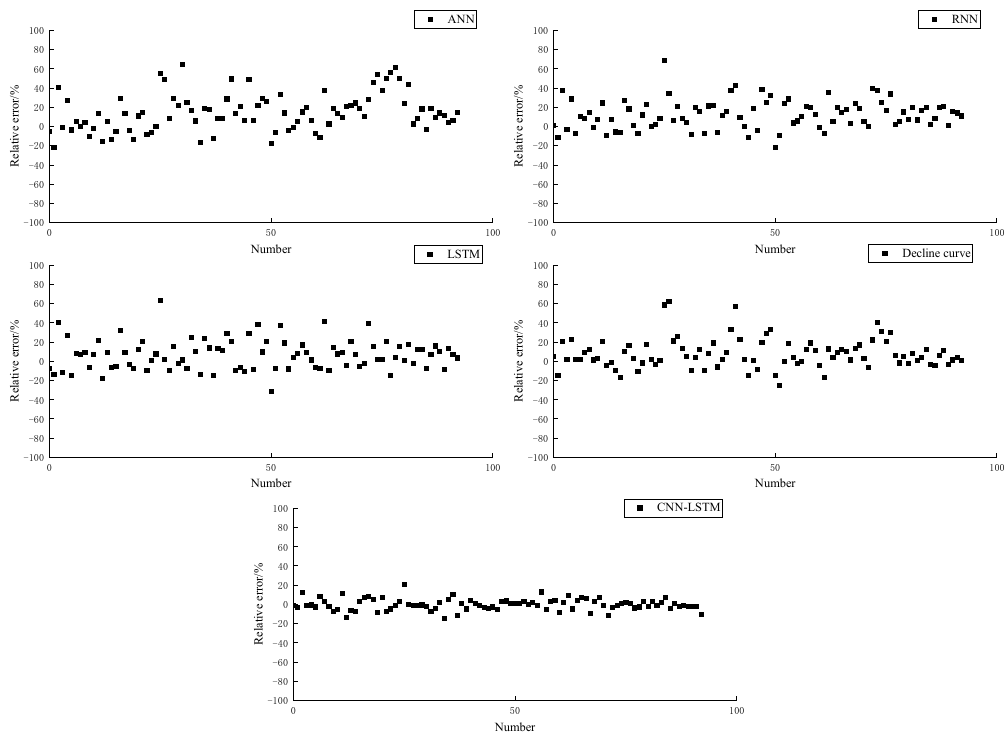
Figure 9. The relative error distribution of the five methods.